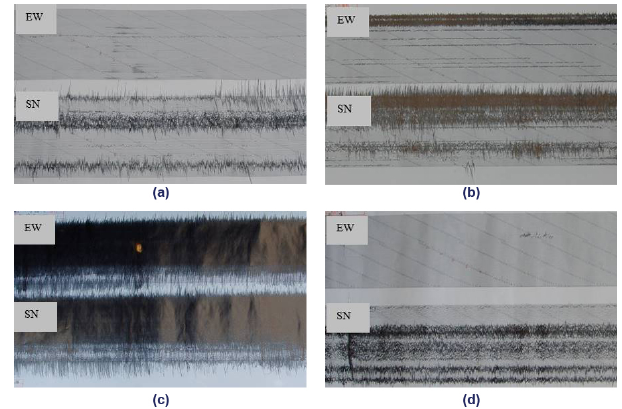
Figure 4. Part of real-time recordings at Gaobeidian station (a) from 09:00LT 13 February to 09:00LT 14 February 2008, (b) from 09:00LT 8 May to 09:00LT 9 May 2008, (c) from 09:00LT 12 May to 09:00LT 13 May 2008, and (d) from 09:00LT 20 May to 09:00LT 21 May